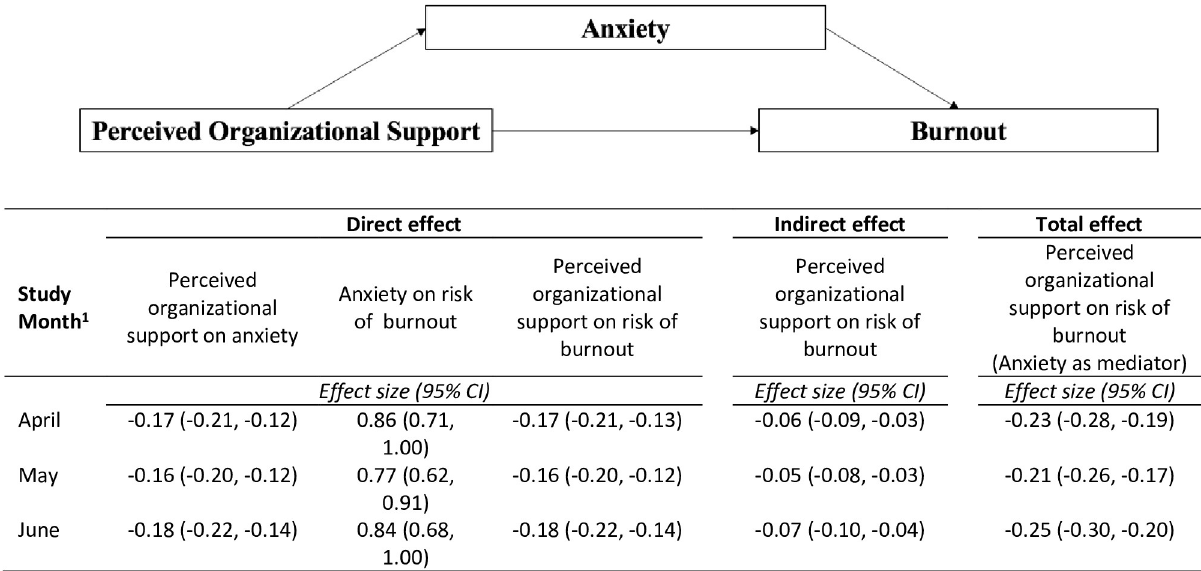
Fig 2. Anxiety mediates the association between perceived organizational support and burnout. 1 Full adjusted models for each study month are available in S5–S7 Tables. Abbreviations: CI, confidence